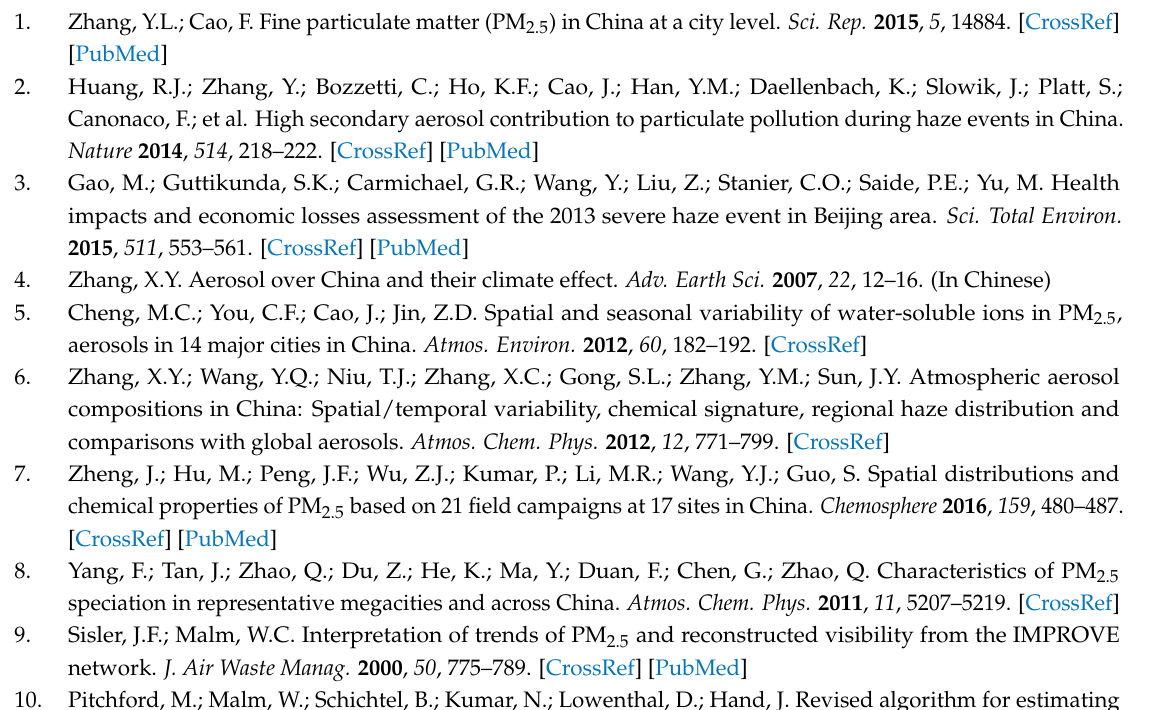
Figure S1: Temporal variations of mass concentrations of aerosols and main chemical components in PM2.5. Figure S2: Day-night variations of PM2.5 and main chemical components in four seasons. Figure S3: Correlation analysis of molar concentrations of SO42-, NO3- and NH4+. Figure S4: Satellite images of fire points during typical biomass burning episodes. (a) 5.28–5.31; (b) 6.6–6.8. (https://firms.modaps.eosdis.nasa.gov/firemap/). Figure S5: Wind rose map from January to November 2014 in suburban